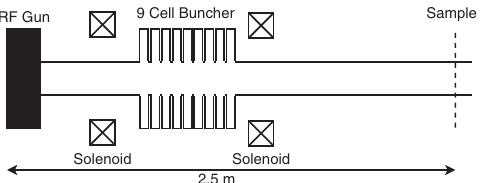
FIG. 3. Layout of the NCRF gun beam line used in the following simulations.